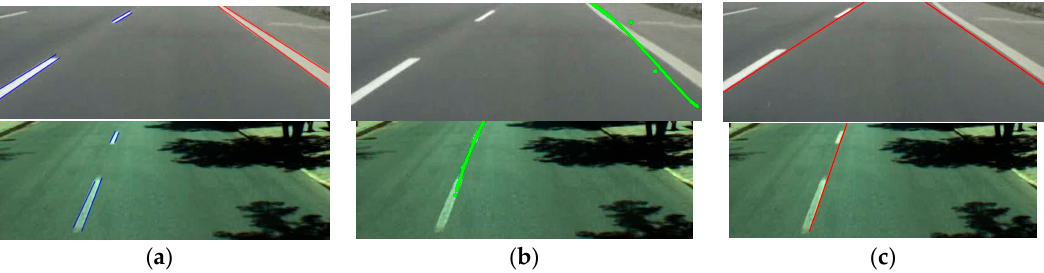
Figure 16. Examples of comparative results of lane detection on SLD datasets: ( a ) our method; ( b ) Aly’s method [12]; and ( c ) Truong and coworker’s method [35].